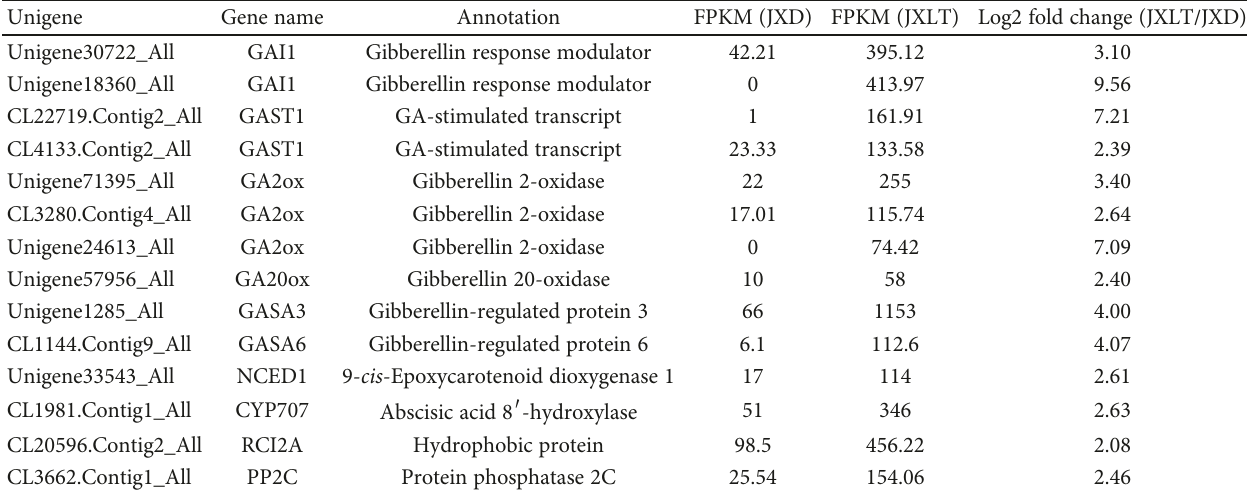
Figure 7: Plant hormone signal transduction and the relative heat map. (a) Plant hormone signal transduction. (b) The heat map of DEGs involved in plant hormone signal transduction. Table 3: Key di ff erentially expressed genes involved in hormone signal transduction of GA and ABA.